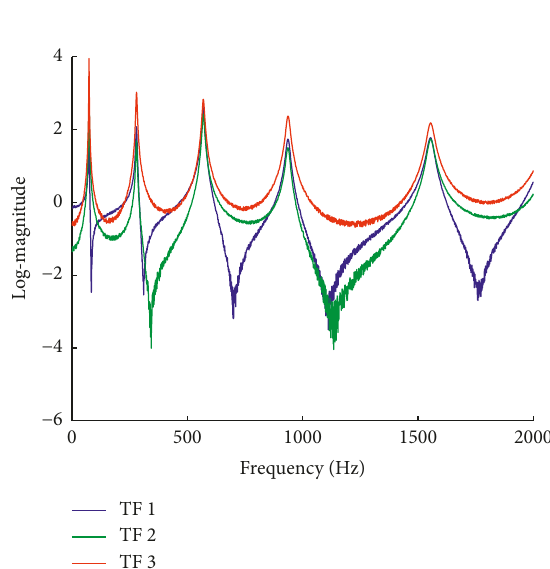
Figure 4: Example of three transmissibility functions (TFs) of a